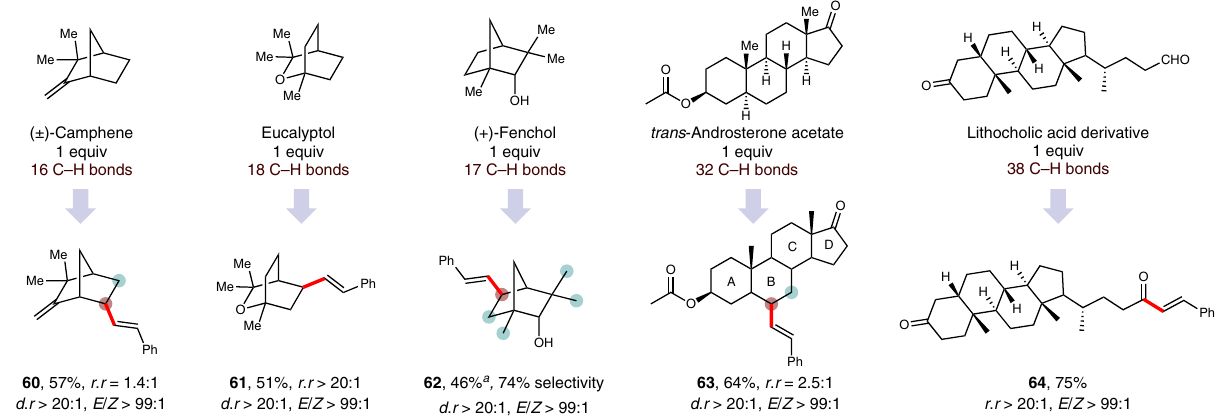
Fig. 4 Late-stage alkenylation of natural products and derivatives. Isolated yields. Standard conditions unless otherwise noted. a Overall yields over three steps: (1) protection: hexamethyldisilazane (0.6 equiv.), ammonium thiocyanate (0.05 equiv.), DCM, 0 °C → RT, 12 h; (2) alkenylation: standard conditions for dehydrogenative alkenylation; (3) deprotection: tetra- n -butylammonium fl uoride (1 equiv.), THF, RT, 12 h. DCM = dichloromethane. THF =